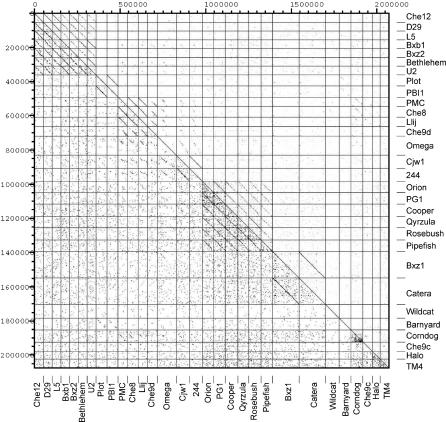
Nucleotide Sequence Comparison of 30 Mycobacteriophage Genomes as Illustrated in a Dotter Plot Using a Sliding Window of 25 bp [63]The lower triangle represents the relationships at an elevated level of gray-scale relative to the upper triangle, revealing weaker sequence relationships.